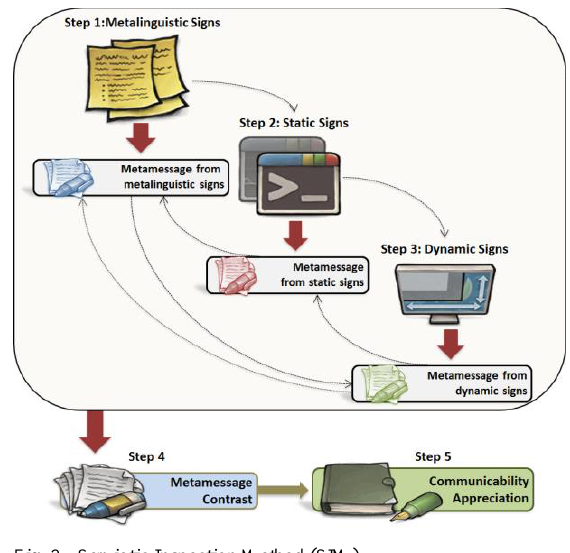
Fig. 2 - Semiotic Inspection Method